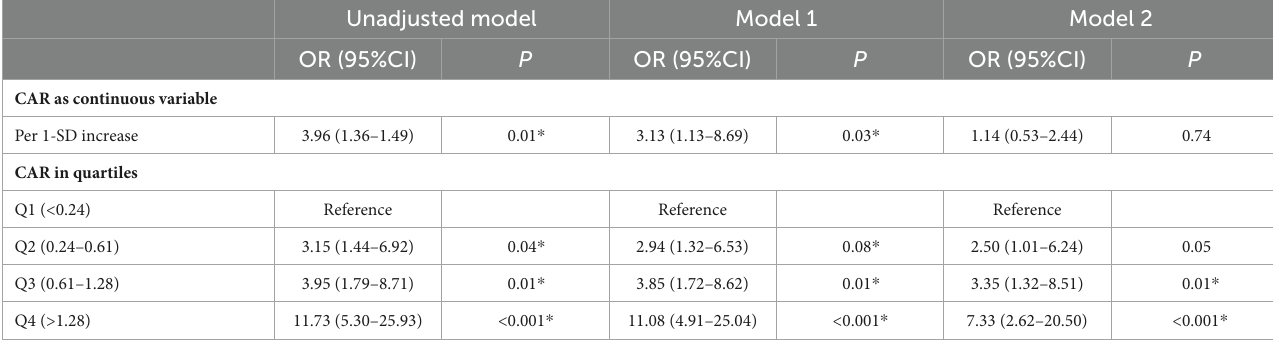
TABLE 4 Multivariate logistic regression to assess the potential relationship between CAR and poor outcome.